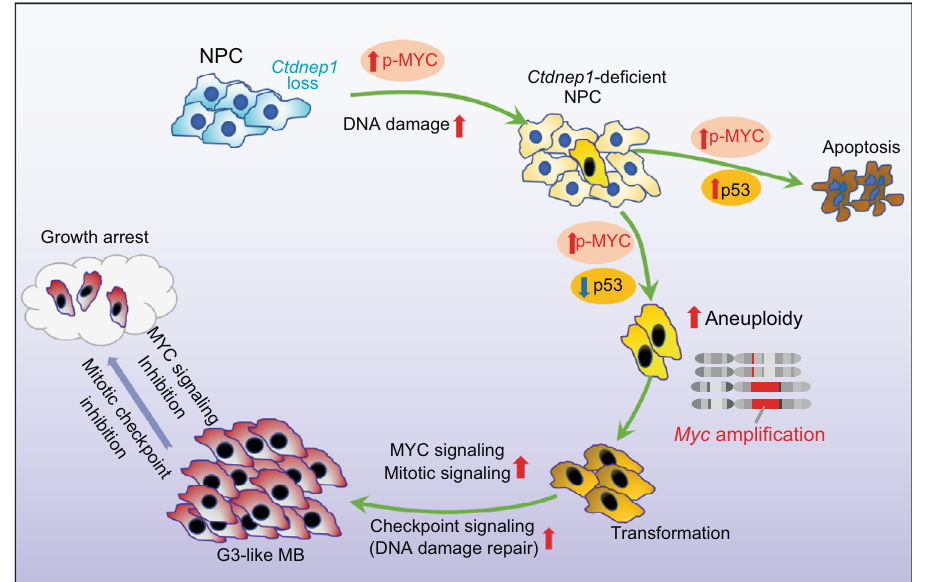
Fig. 8 | A schematic model for G3 MB transformation induced by CTDNEP1- de fi ciency. CTDNEP1depletionormutationinneuralstem/progenitorcells(NPCs) resultsinMYCactivationalongwithDNAdamageandincreasedp53levels,leading to apoptosisatthe earlystages.However,apopulationof CTDNEP1-de fi cientNPCs acquires the selective fi tness advantage to survive by inducing p53 loss or down- regulation and triggers genomic instability and aneuploidy with Myc gene